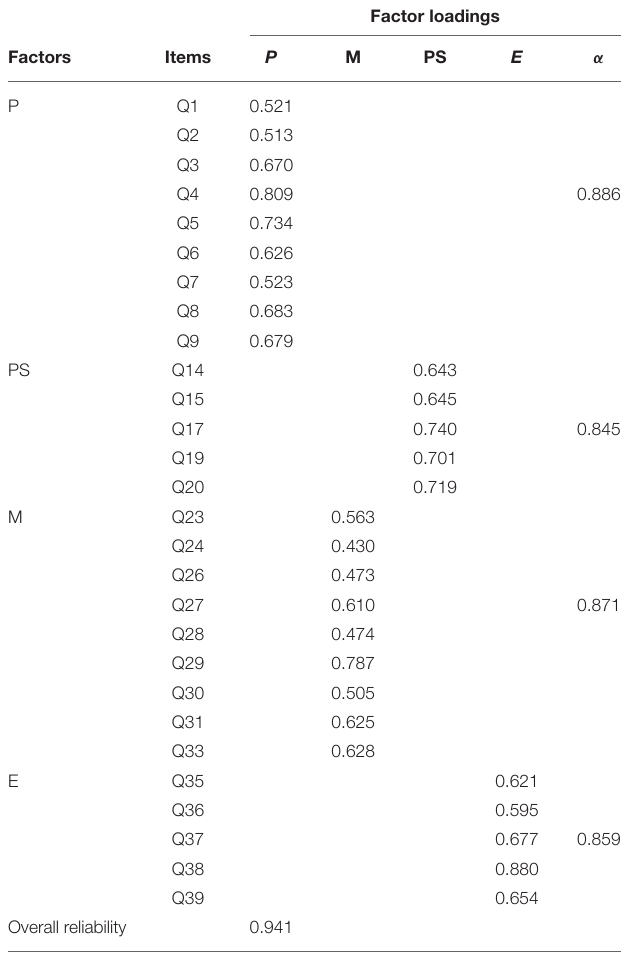
TABLE 2 | Results of EFA and the reliabilities of the four-factor